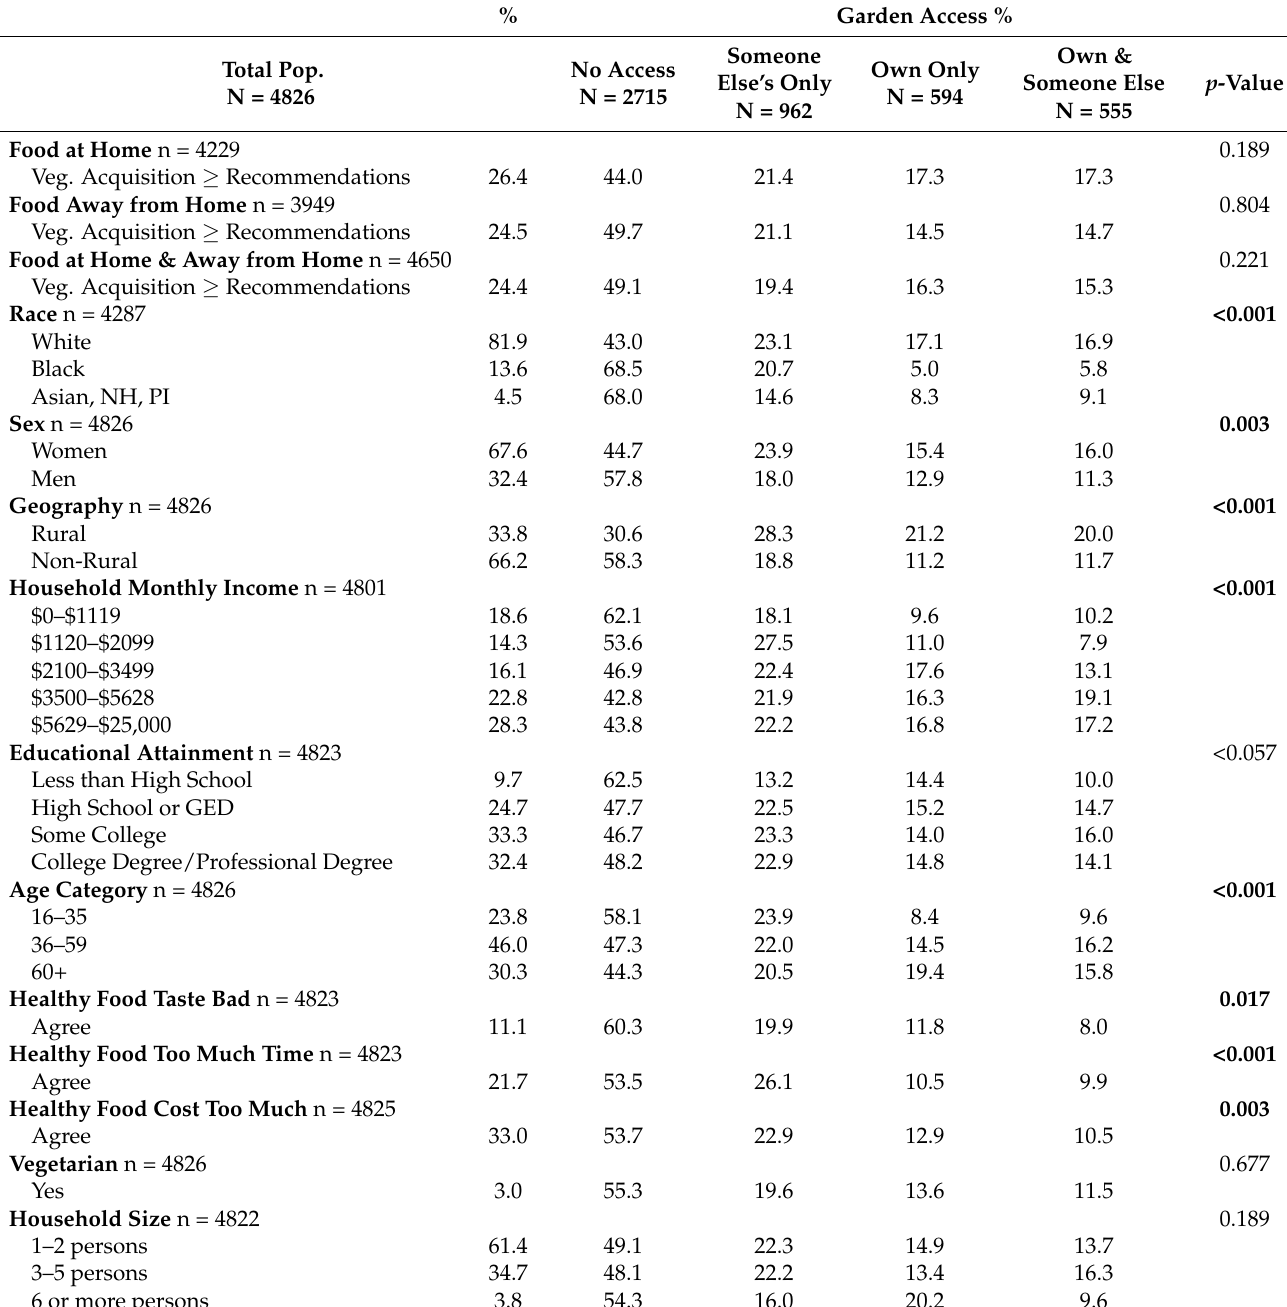
Table 1. Weighted distribution of household garden access by select behavioral and demographic characteristics in the National Household Food Acquisition and Purchase Survey